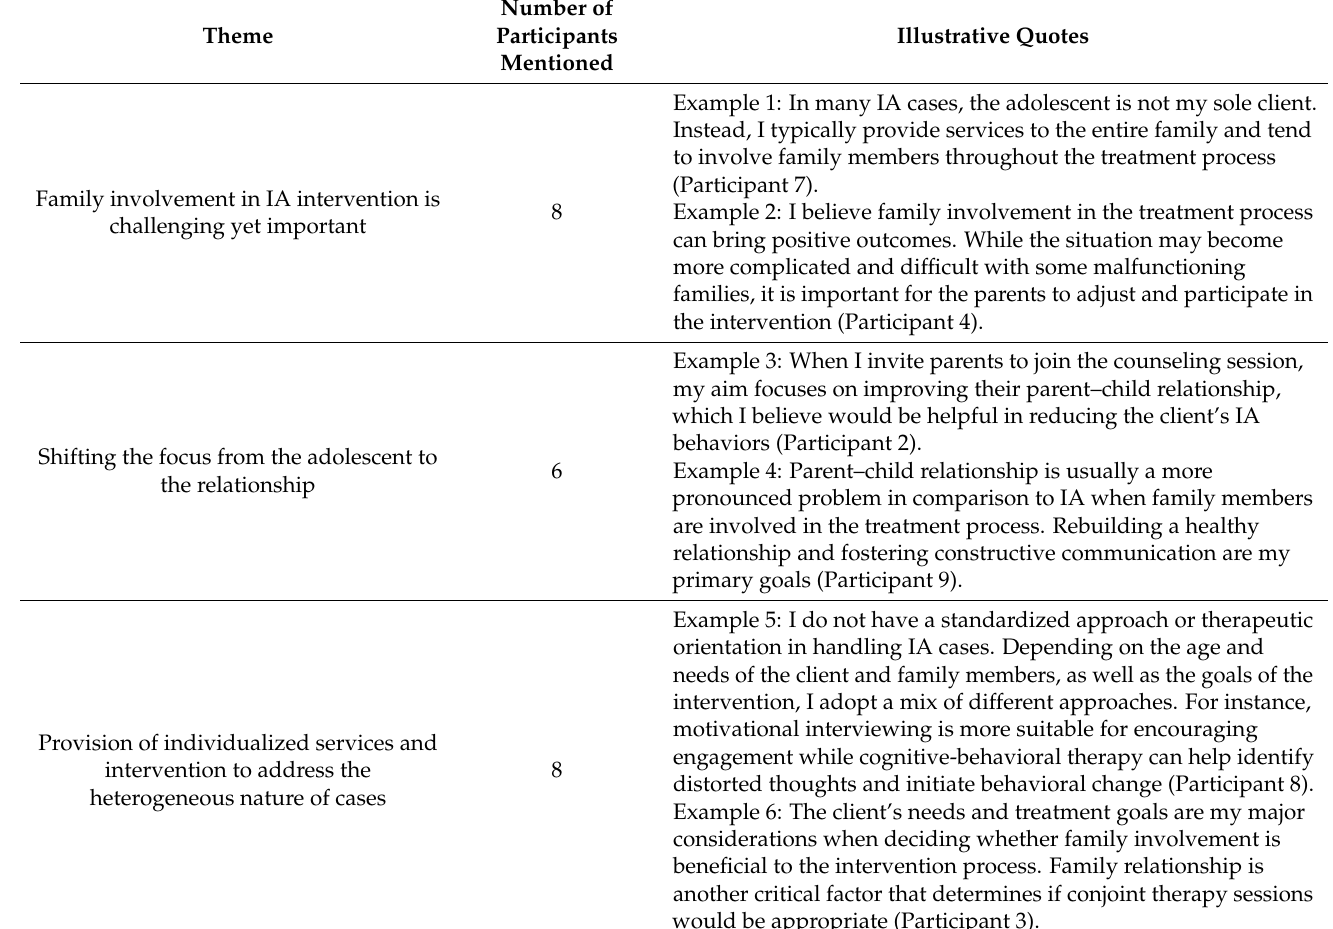
Table 4. Themes and illustrative quotes from thematic